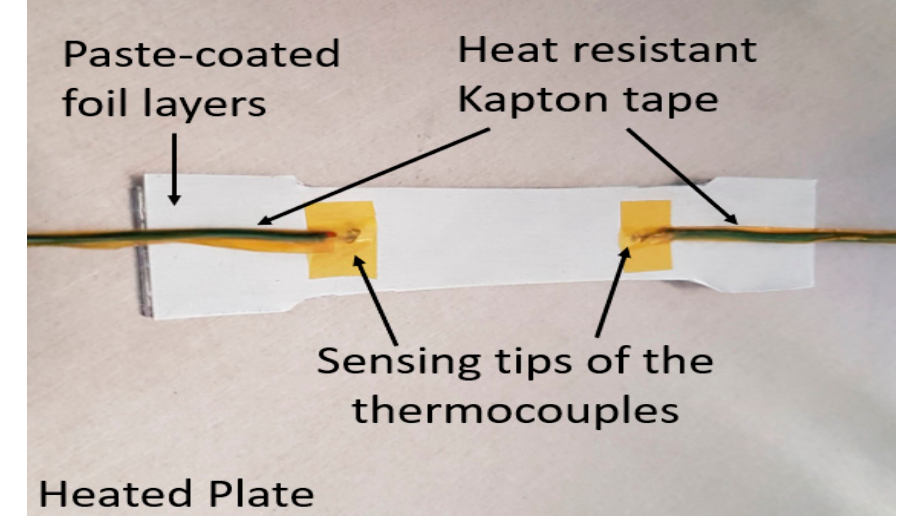
Figure 2. Experimental setup for heating time.